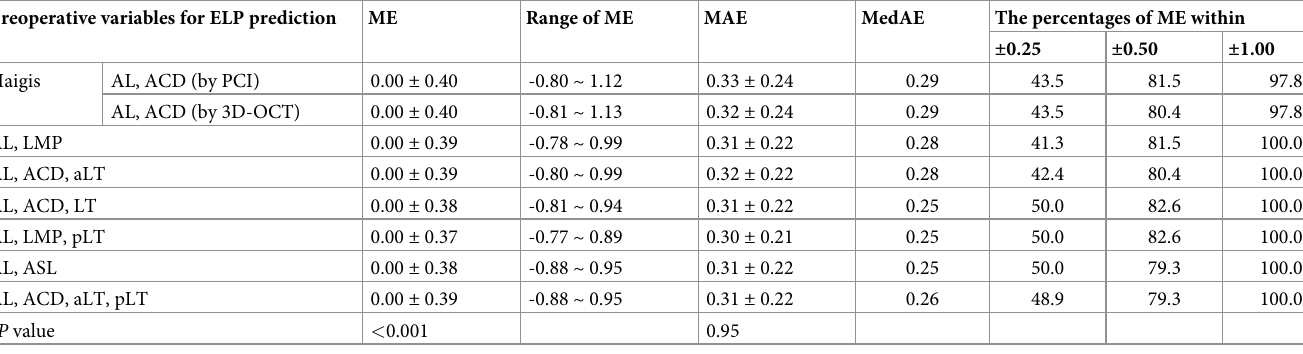
Table 5. Predictive accuracy derived from each combination in a training set (n = 92). Preoperative variables for ELP